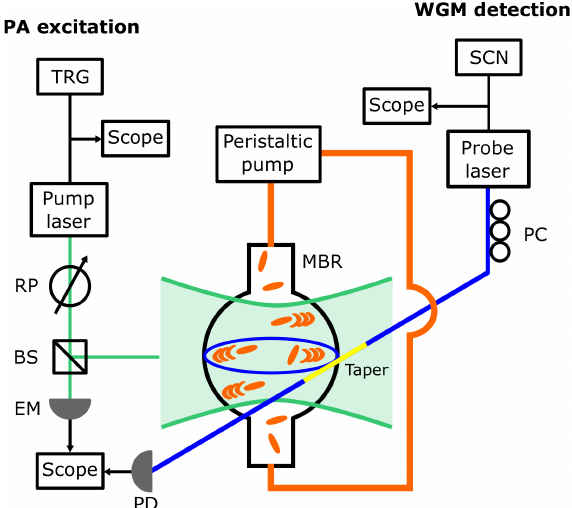
Figure 1. Sketch of the experimental setup. The following abbreviations are used: TRG, waveform generator used to trigger the pump laser and the oscilloscope acquisition; RP, rotatable polarizer used to set the excitation fluence; BS, beam splitter; EM, pyroelectric energy meter; SCN, waveform generator used to scan or finely set the probe laser wavelength; PC, fiber polarization controller; PD, photodiode. The microbubble resonator (MBR) area is exaggerated to highlight the MBR illumination through the pump laser and the use of a tapered fiber (taper, yellow segment of the optical fiber) to couple the probe laser to the Whispering Gallery mode